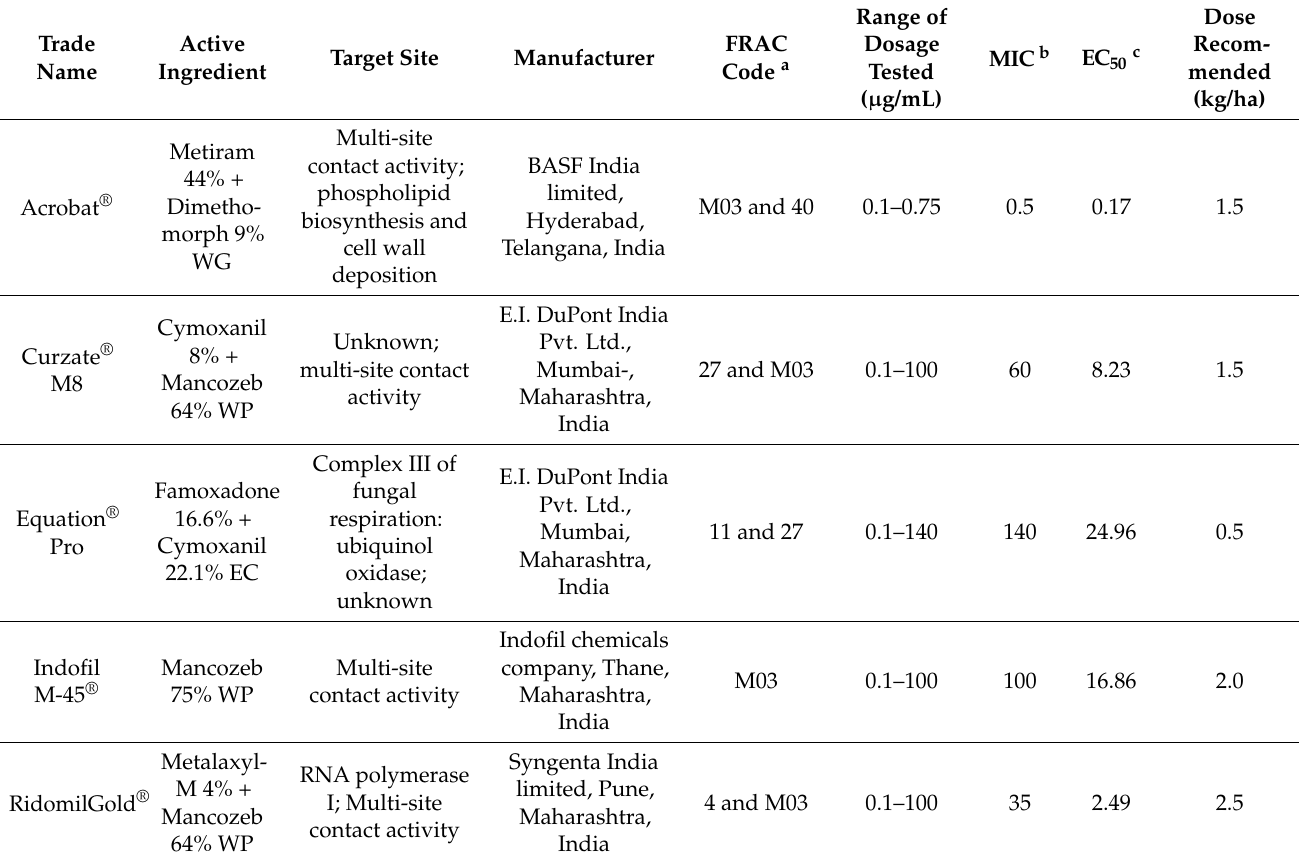
Table 1. Details of anti-oomycetes fungicides and their effect on P. cajani